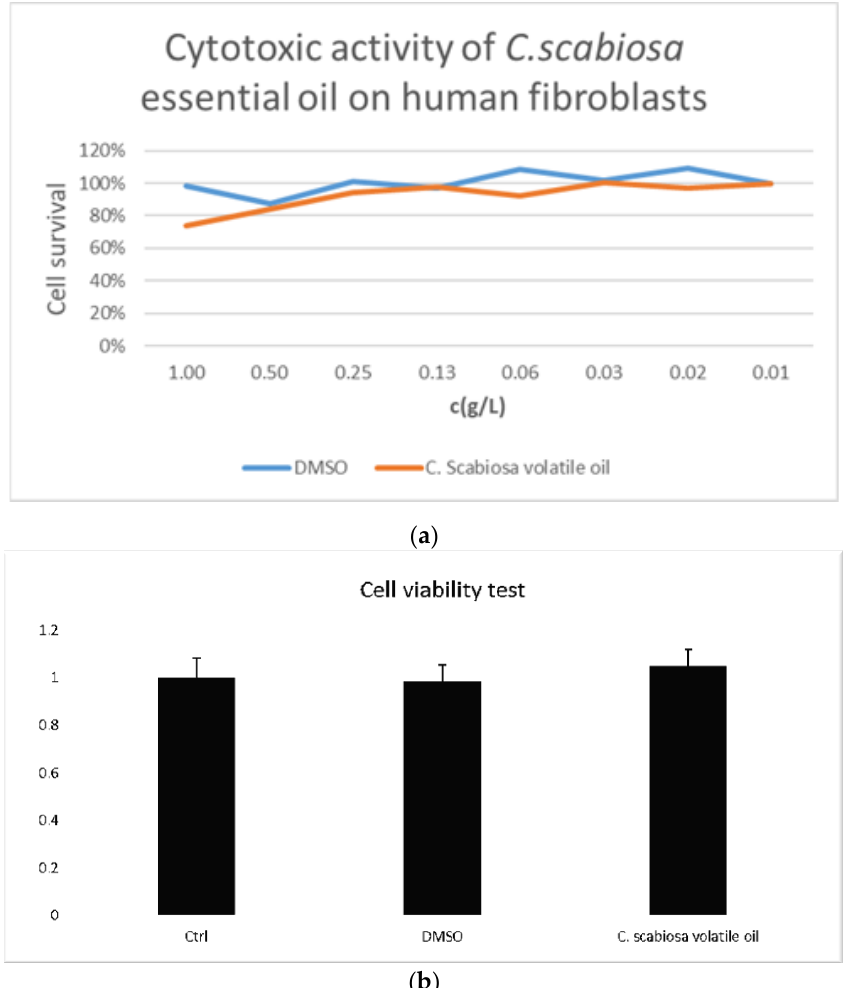
Figure 1. Centaurea scabiosa volatile oil tested on primary human skin fibroblasts with the MTT assay in eight different concentrations in the range of 0.01 – 1 g/L ( a ) The result for essential oil presents the average of the results for eight different concentrations of C. scabiosa essential oils, in triplicates ( b ). We compared the biological activity of the studied volatile oils to known volatile oils The classical karyological method revealed 2n = 20 + 2B chromosomes in C. scabiosa of edible Centaurea species because Centaurea species are very poorly known